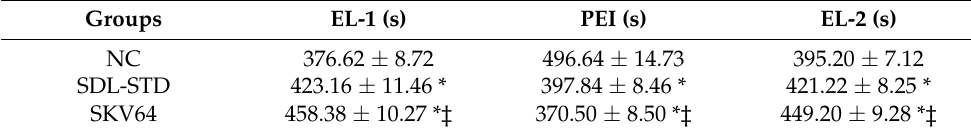
Values are expressed as mean ± S.E.M., n = 6 rats/group. * indicates significance compared to NC group at p < 0.05. ‡ indicates significance compared to SLC-STD group at p < 0.05. Table 3. Effect of SLC-KV64 on the ejaculation latency in the 1st series (EL-1), post ejaculatory interval (PEI) and ejaculation latency in the 2nd series (EL-2) of male rats. Groups